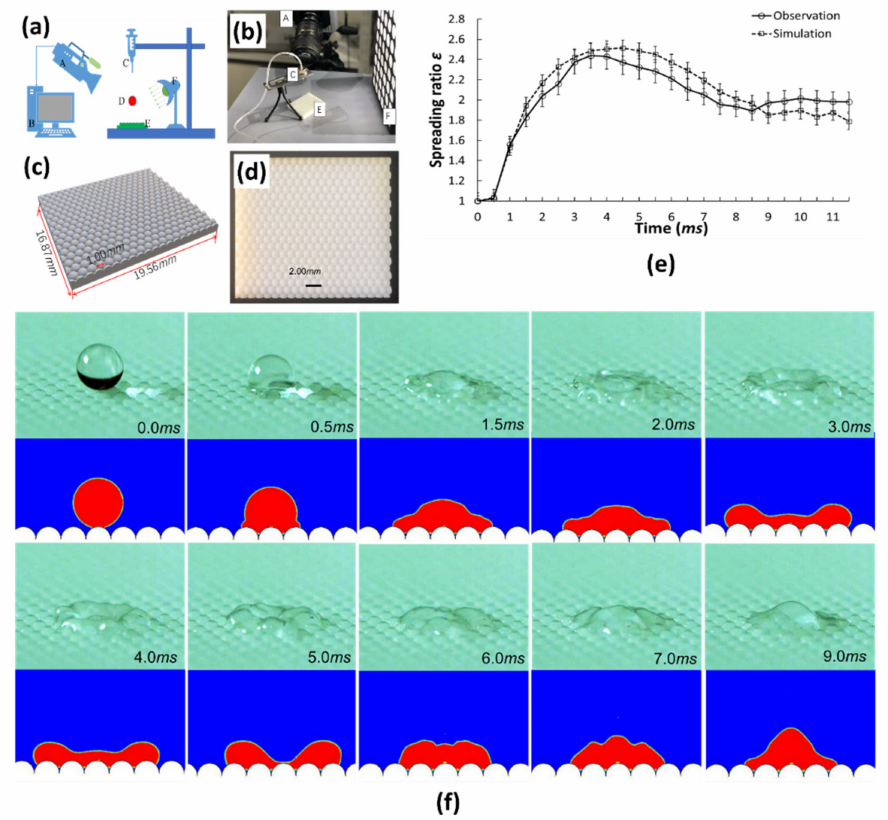
Figure 3. Comparison of observation experiment and simulation. ( a ) is the schematic diagram of test equipment, ( b ) is the real pictures of experimental equipment (A. CCD high-speed camera, B. computer, C. syringe with a needle, D. water droplet, E. multiple spherical substrates, F. light source) ( c ) is the CAD design model of the substrate, ( d ) is the solid substrate. ( e ) are the curves of spreading ratio with time observation experiment and simulation. ( f ) is the droplet spreading deformation process, where the red region was the droplet, and the blue region was